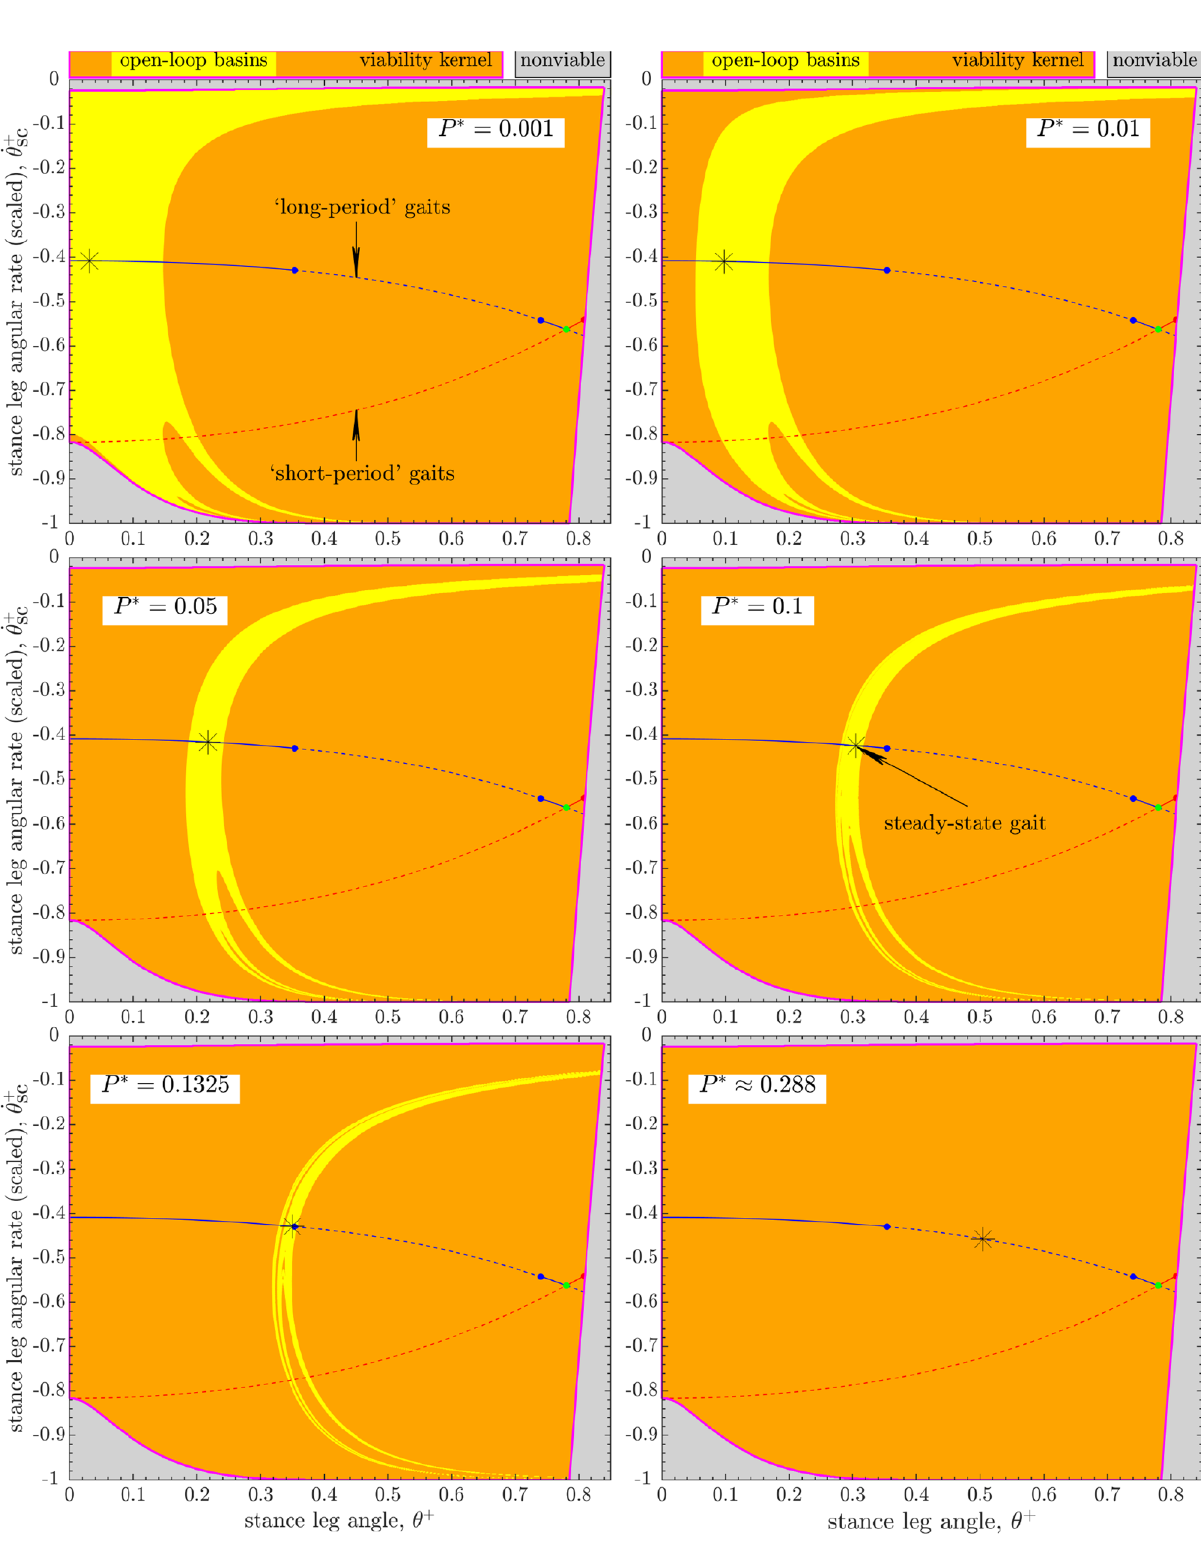
Figure 4. Evolution of the open-loop ( P k := P ∗ , constant) walker’s basin of attraction within the viability kernel V of its long-period steady-state gait ( ) with increasing push-off impulse P ∗ . Compare to Fig. 5. The open-loop basin at P ∗ = 0.001 is similar in structure to that with no push-off ( P ∗ = 0 ) that shares boundaries with V (Fig. 3b). As P ∗ increases, the basins shift to the right within V , while shrinking progressively for P ∗ (cid:31) 0.01 . The first period-doubling bifurcation occurs at P ∗ ≈ 0.13571 , so that the open-loop basin at P ∗ ≈ 0.288 is empty. Basin areas ( % of the area of V ) for increasing P ∗ : { 8.32, 8.36, 5.38, 3.11, 1.46, 0 } %